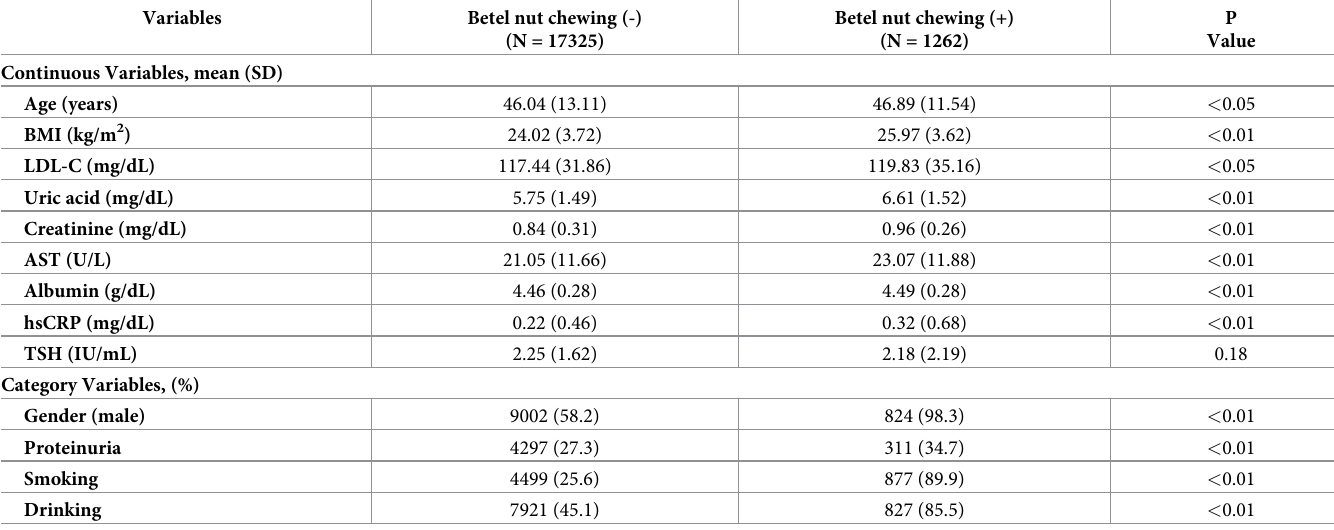
Table 1. Characteristics of study sample with or without betel nut chewing. Variables Betel nut chewing (-)